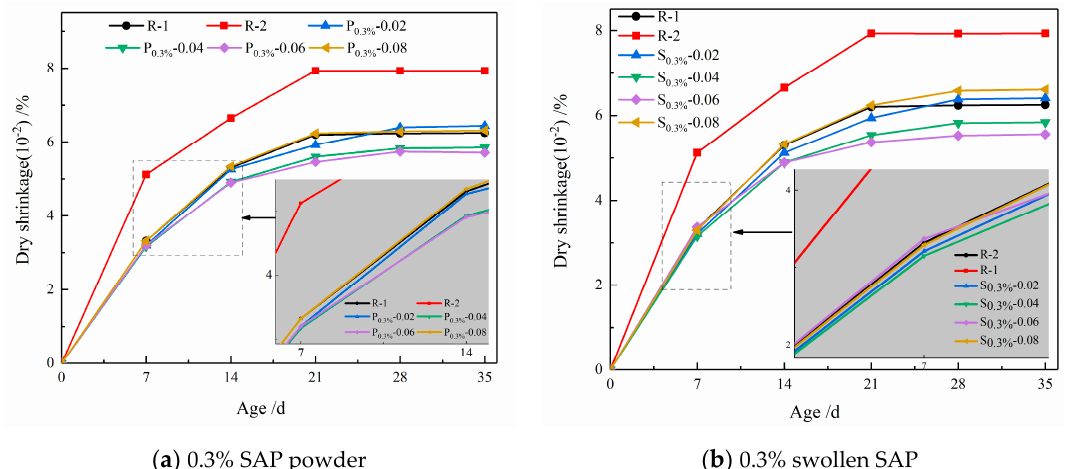
Figure 8. Drying shrinkage of cement mortar with different entrained w/c values.